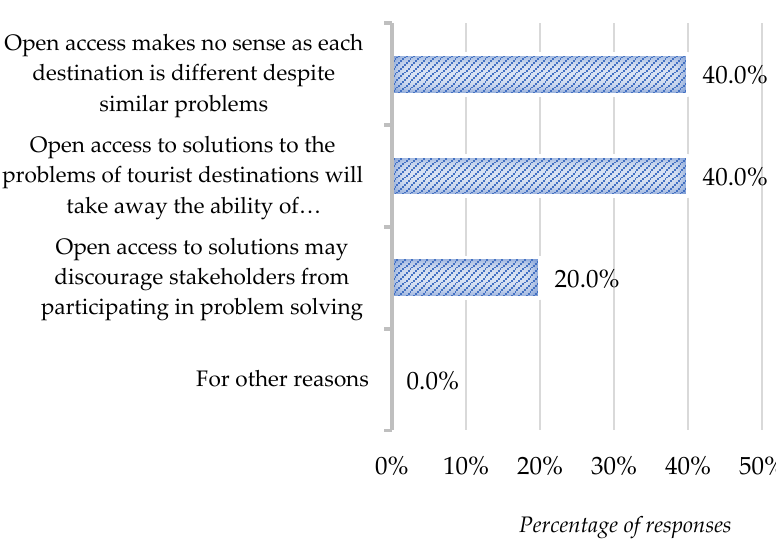
Figure 5. Distribution of answers to the question: ‘ How should such open innovation solutions be imple- mented? ’ Source: Own study.